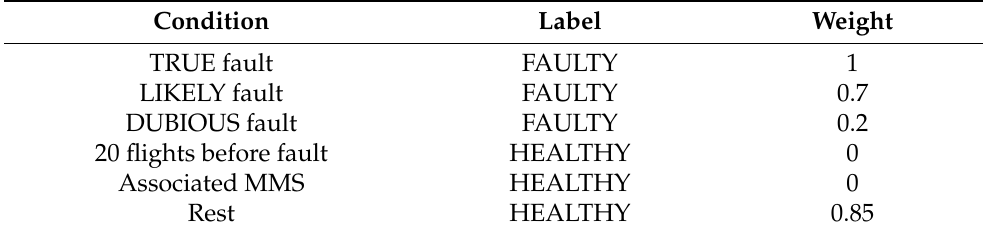
Table 7. Rules on sample allocation of health status label and weight.